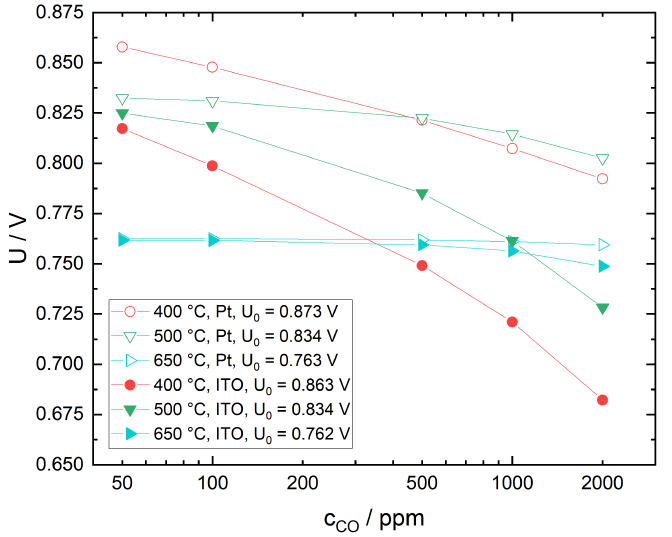
Figure 9. Comparison of sensor voltages for a sensor with Pt cermet versus ITO sensing electrode as a function of CO concentration in N 2 with 12.5 vol% O 2 for different temperatures. Baseline sensor voltages in the absence of CO are given by U 0